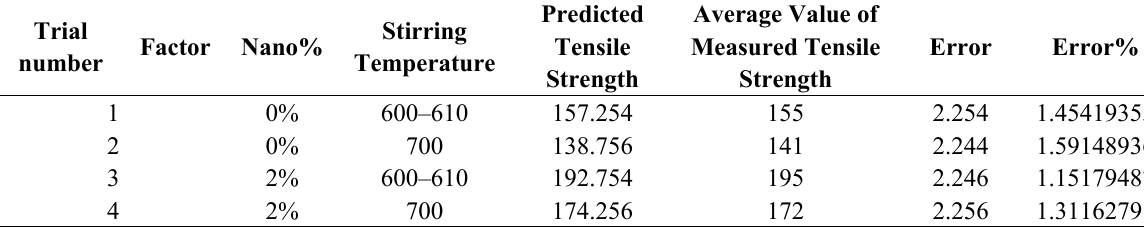
Table 1. Orthogonal L4 array for ANOVA analysis of previous